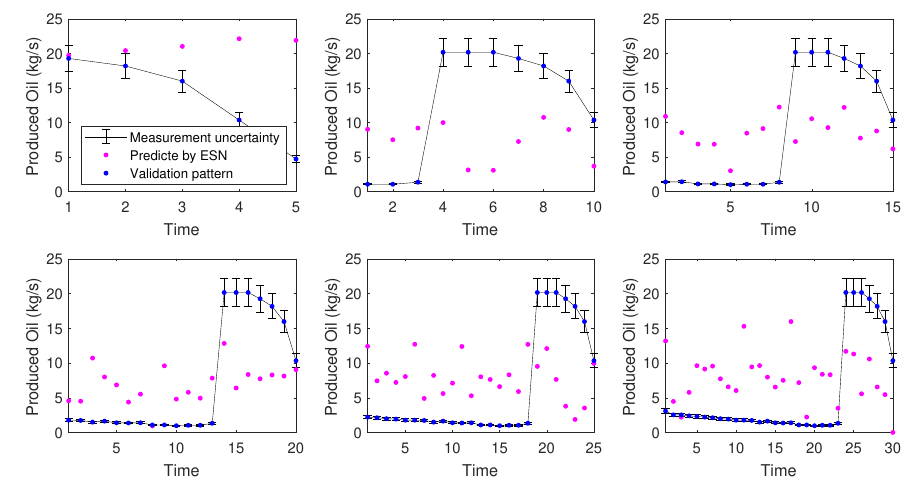
Figure 12. Prediction in a time horizon—3 months time